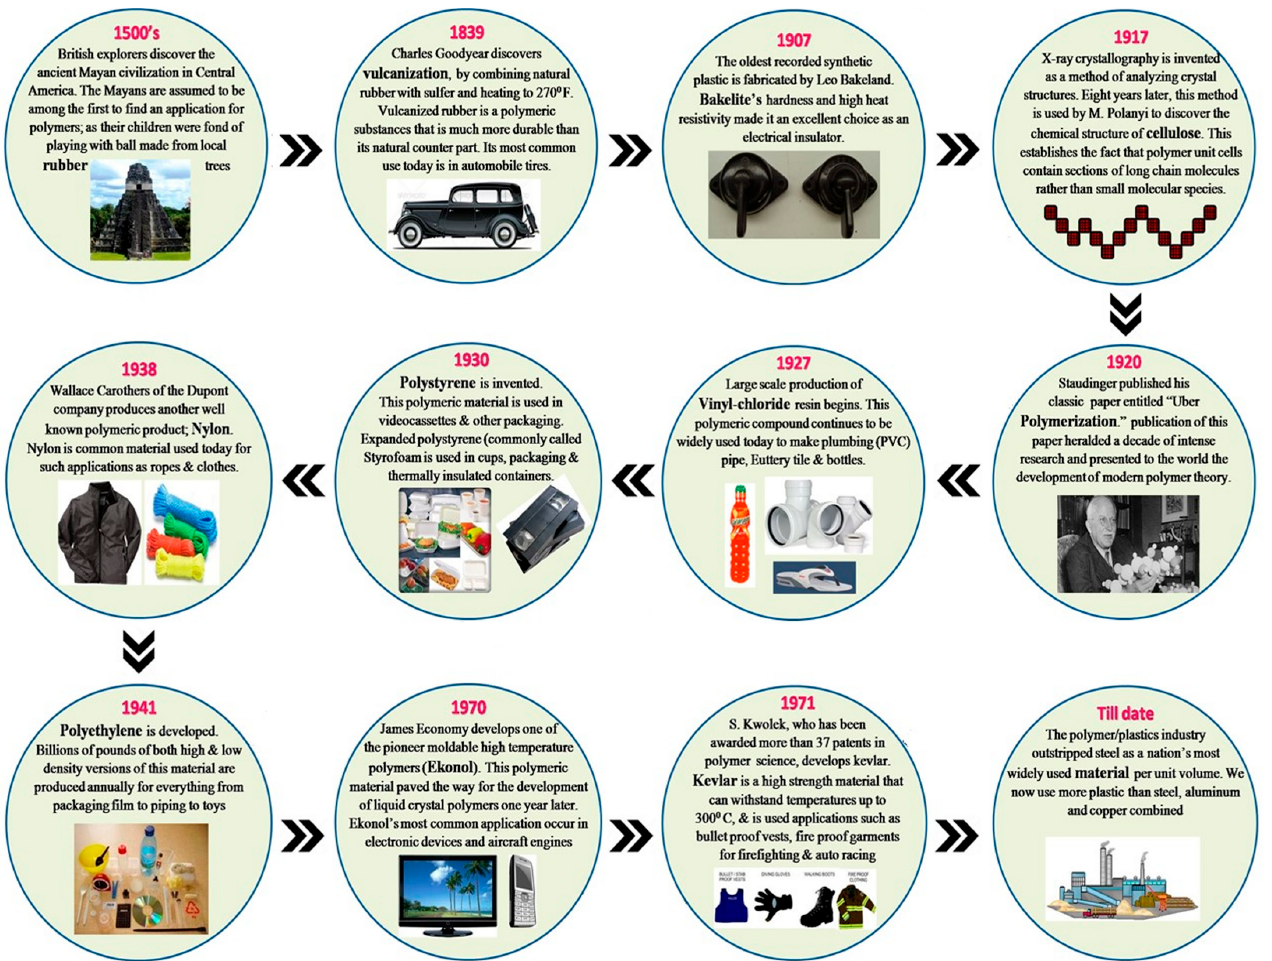
Figure 1. Progressive developmental journey of polymers.